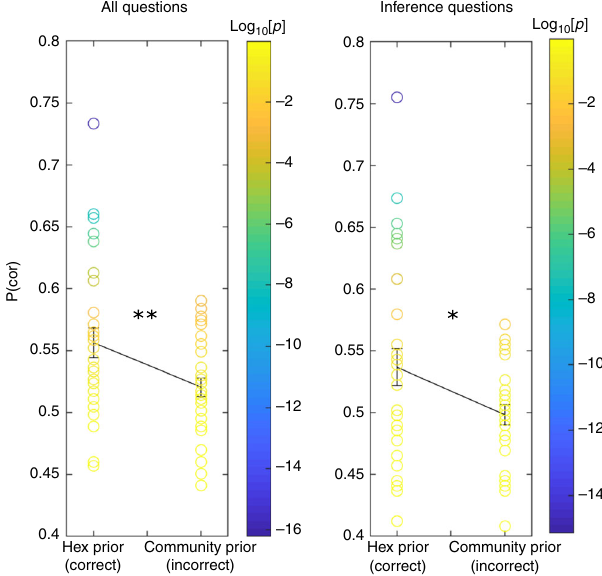
Fig. 5 Transfer of structural knowledge allows inference of unobserved links (Hexagonal graph). Participants had to indicate which of two pictures is closer to a target picture. Participants that reached the second day of our task with the correct prior expectation over the structural forms performed signi fi cantly better in such task compared to participants with the wrong structural prior (left panel) (30 participants in each group). They were able to answer these questions signi fi cantly above chance even when there were links that were never observed, and they had to choose between two pictures with an identical number of observed links to the target (right panel). One-tailed t test. **p < 0.01, * p < 0.05. Error bar: SEM. Colorcode: Log 10 ( p